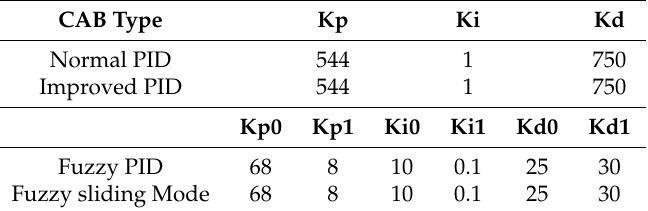
Table 2. PID parameters for different